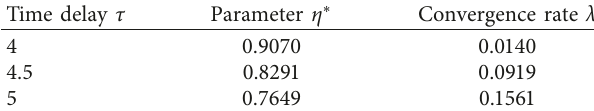
Table 1: The convergence rate λ for different time delays.